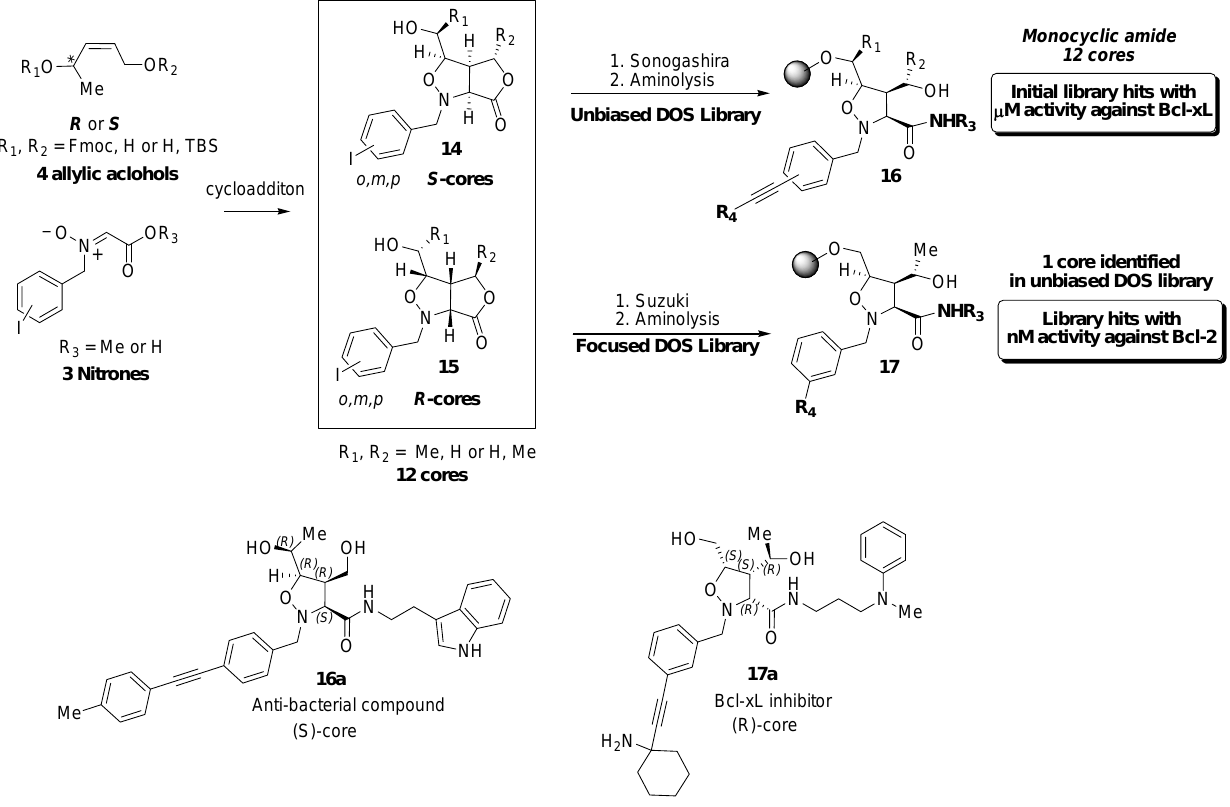
Figure 6. Isoxazolidine based Bcl-2